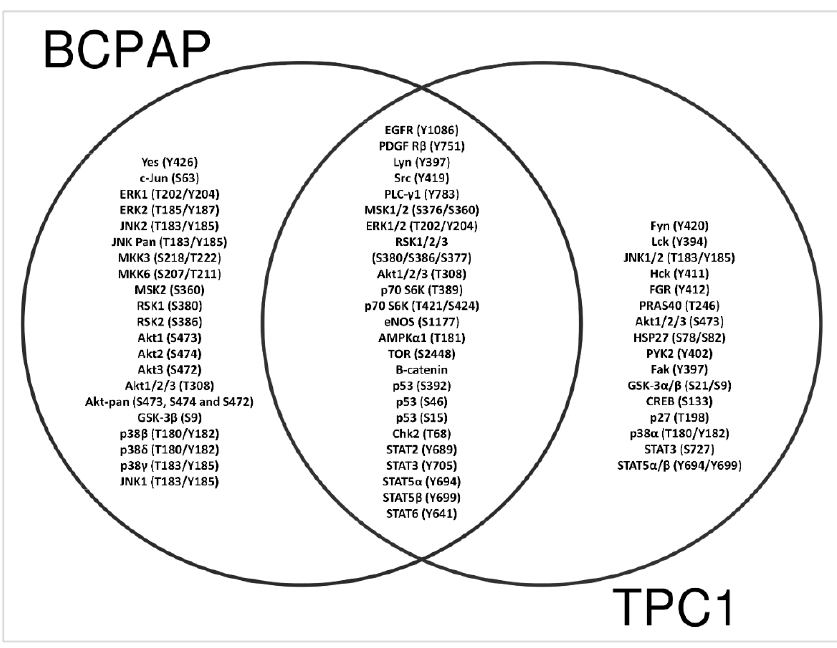
Figure 7. Venn diagram showing the kinases that were modulated in both cells (intersection) or either in BCPAP or TPC1 LIMD2-edited cells.